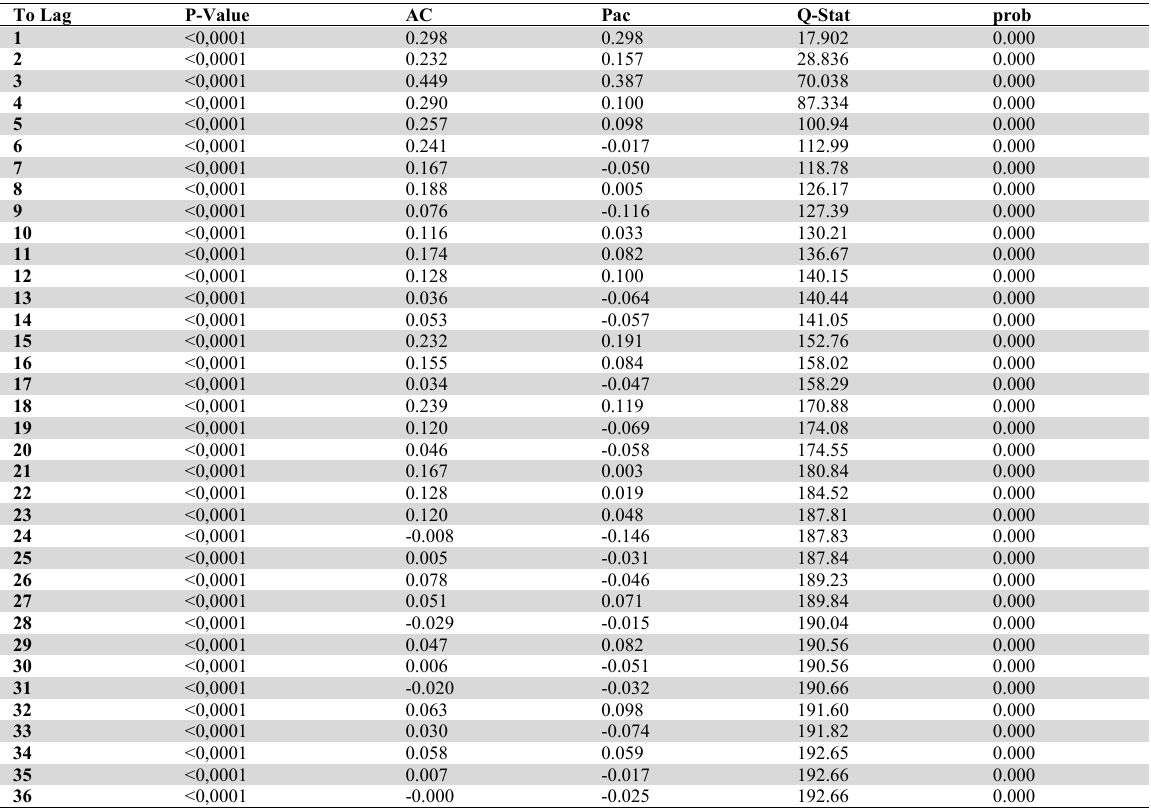
White Noise Test